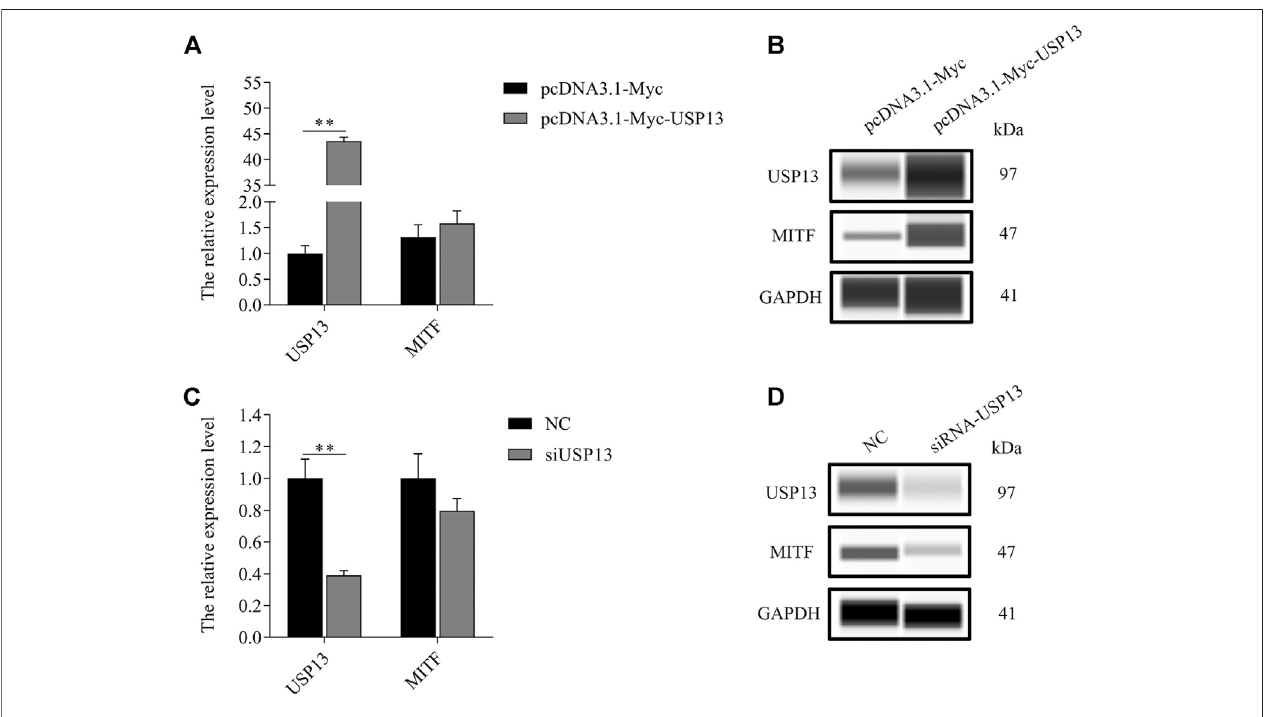
FIGURE 4 | Exogenous USP13 regulated endogenous MITF protein. (A) MITF-M mRNA expression was determined in USP13 overexpressing cells. (B) Endogenous MITF protein was detected in USP13 overexpressing cells. (C) The MITF-M mRNA expression in USP13 knockdown cells treated with siRNA. (D) Endogenous MITF protein was detected post USP13 overexpression. Each sample had three replicates. ** indicates p <